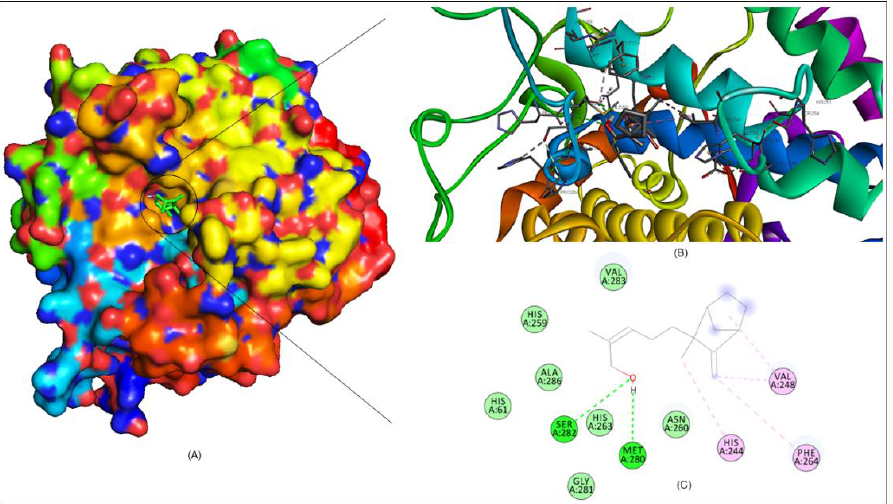
Figure 8. Molecular interaction studies showing the santalol–PPO3 tyrosinase complex. ( A ) The surface model of santalol-PPO3 tyrosinase complex was in active pocket. ( B ) Cartoon representation of tyrosinase protein complex with santalol showing the interacted residues in expanded form. ( C ) The 2D interaction analysis of complex files was done by BIOVIA here, and the different color showing bonds are light green—carbon hydrogen bond; green—hydrogen bond; and purple—Pi alkyl